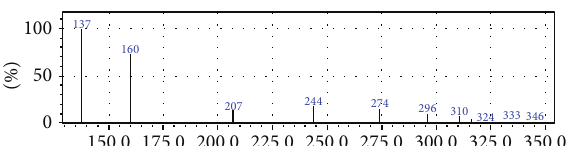
Figure 10: Mass spectra for standard 9,10-Anthraquinone after exposure to UV